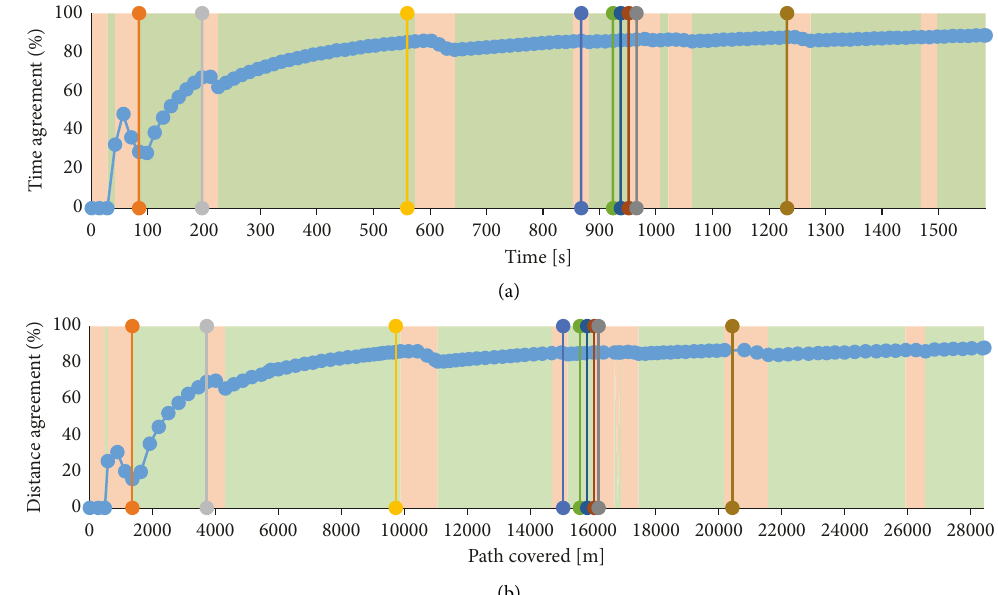
Figure 10: Diagrams of the RTD software prototype’s recognition precision with respect to time (a) and the path length (b), respectively, for the chain described in Table 21. The duration of this chain is about 27 minutes; the total path length covered by the ego vehicle is about